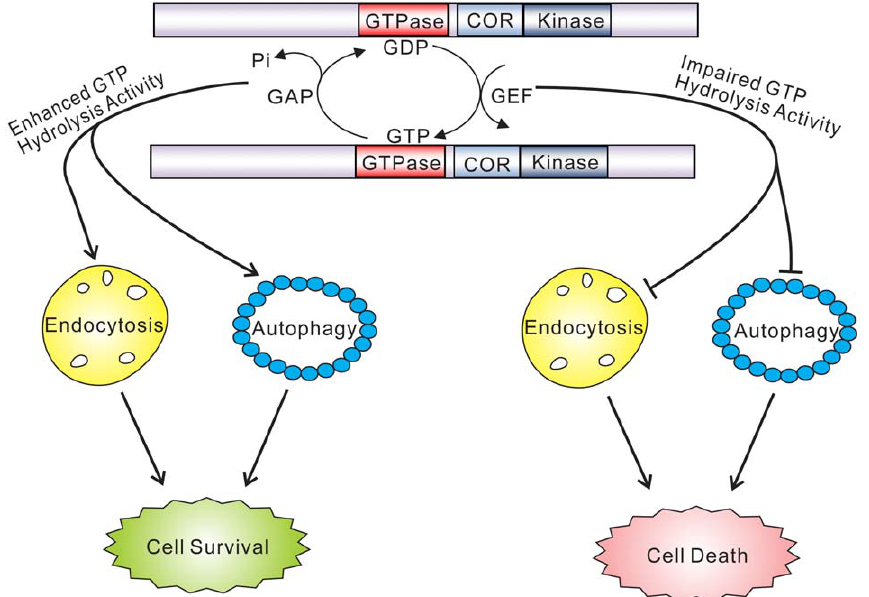
Figure 8. GTPase activity plays a key role in the pathobiology of LRRK2. GTP hydrolysis activity but not GTP binding or kinase activity is sufficient to modify toxicity induced by truncated human LRRK2 variants. Truncated GTPase variants with impaired GTP hydrolysis induce marked defects in the endocytic vesicular trafficking and autophagy pathways, which may underlie LRRK2-induced toxicity. Truncated GTPase variants with enhanced GTPase activity show reduced LRRK2-induced toxicity. Lines with arrows indicate promoting or activating effects while lines with blunt ends indicate inhibitory effects.